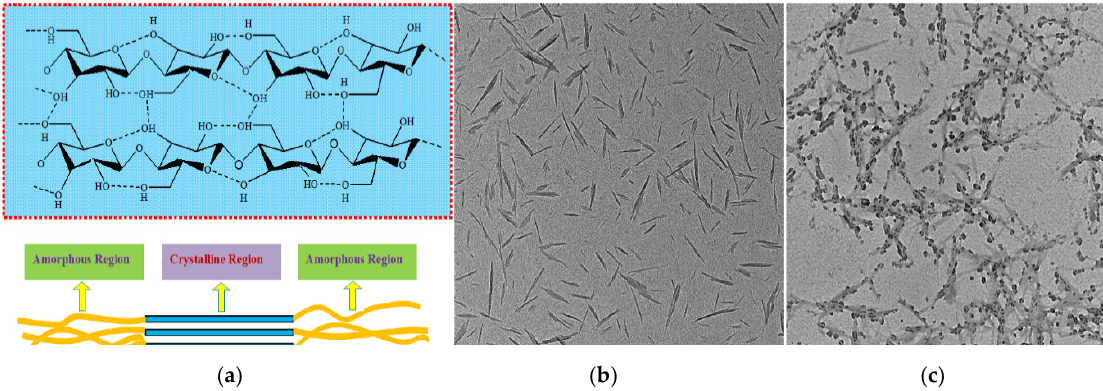
Figure 25. Molecular structure of nanocellulose macromolecule ( a ), TEM image of nanocellulose ( b ) and nanocellulose-SO compounds ( c ) [9,87,88].